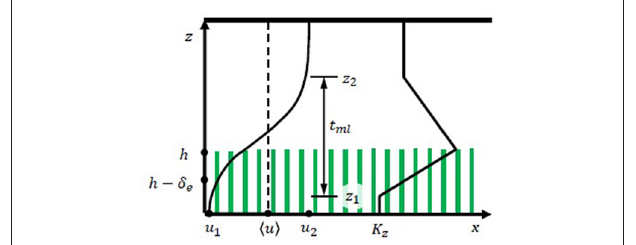
FIGURE 1 | Schematic of time-averaged mixing layer velocity profile u ( z ) within a submerged canopy. The canopy height is h . The time-mean velocity at the bed and far above the canopy are denoted u 1 and u 2 , respectively, with u 2 u 1 . The mixing layer extends between z 1 and z 2 ( t ml 1 u = − with endpoints defined